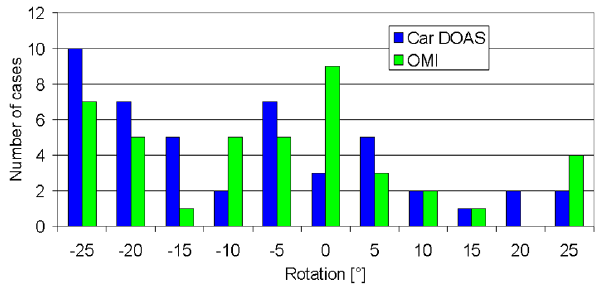
Figure 8. Frequency distribution of the optimum rotation angles for the comparison of the CHIMERE data with car-MAX-DOAS observations (blue) and satellite observations (green). Here not only results for large circles (like in Fig. 6), but for all measurements are